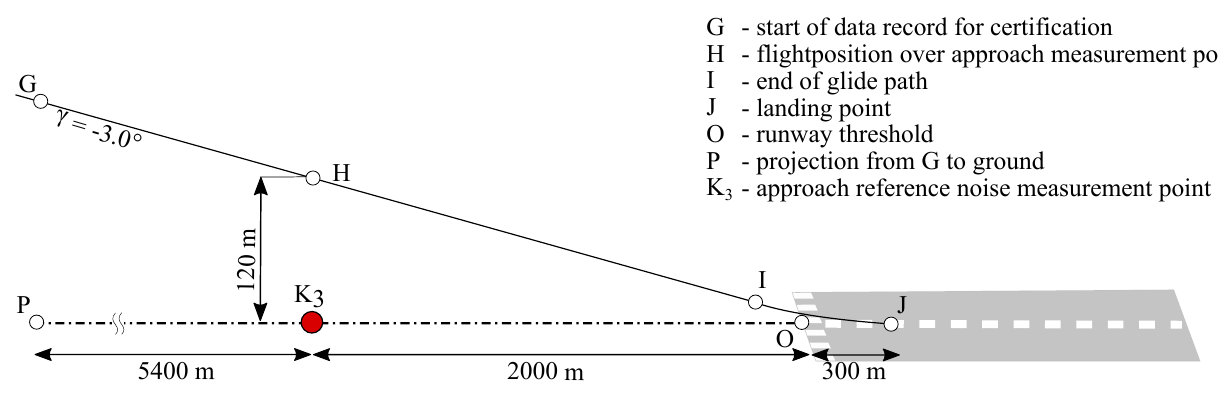
Figure 2. Reference profile of subsonic aircraft for noise certification with approach reference measurement point and